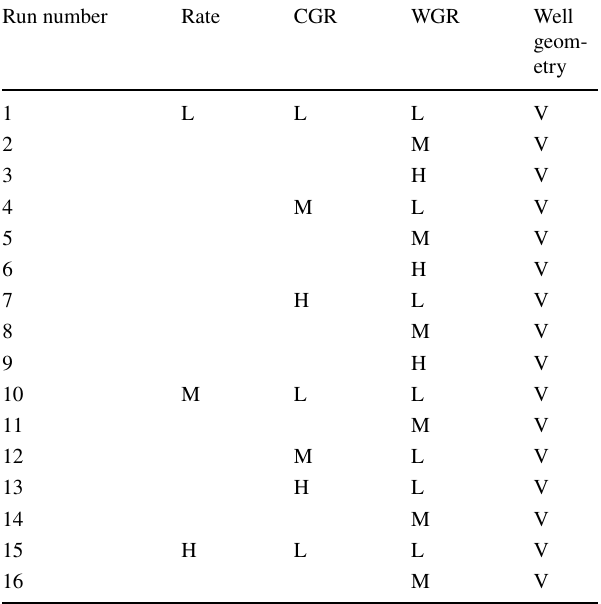
Table 4 Classification of different model runs for vertical wells